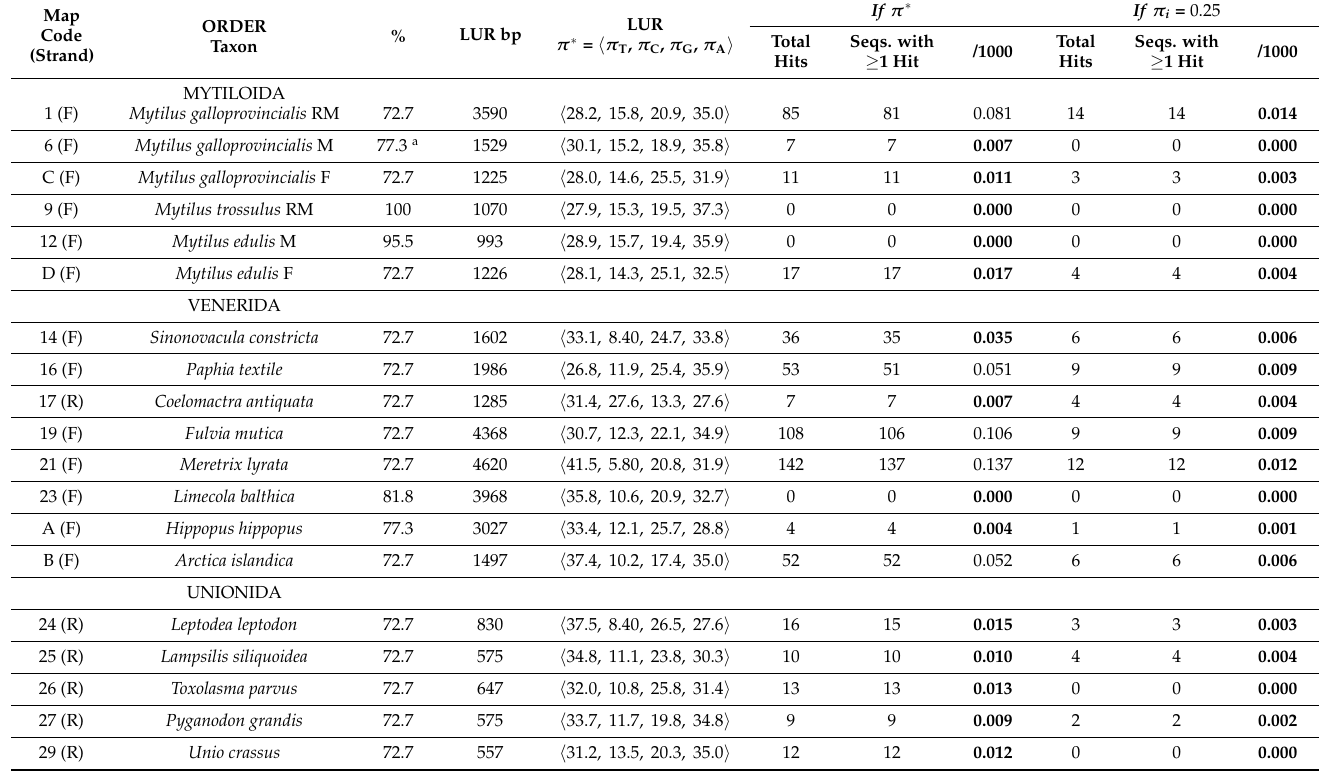
Table 1. The probability of observing a comparable or better alignment match as those identified in the sliding window analysis. Probabilities are assessed based on generating 1000 random sequences of equal lengths to each Large Unassigned Region (LUR) under investigation. Reported are the total number of matches (Hits) found in the 1000 random sequences, the number of replicates (Seqs) where at least one or more matches were found, and the final probability of each LUR having a similar (or better) match as those found in our earlier analyses (/1000 replicates). Sequences were generated considering both the nucleotide frequency for each LUR ( π ∗ ) or assuming equal frequencies ( π i = 0.25, for i equal to A, C, G, or T ) . Frequencies are those of the forward (F) or reverse strand (R) depending on the orientation of the putative STE motif. Significant values (bold) are those where the number of replicates with one or more hits is ≤